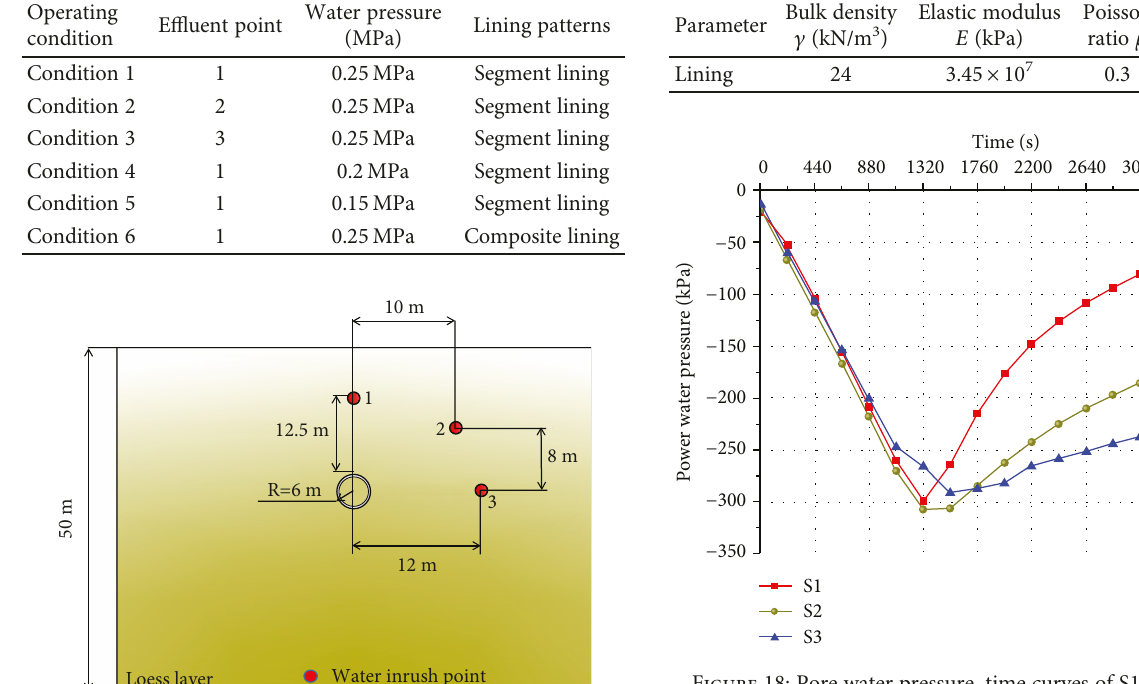
Figure 18: Pore water pressure – time curves of S1, S2, and S3.